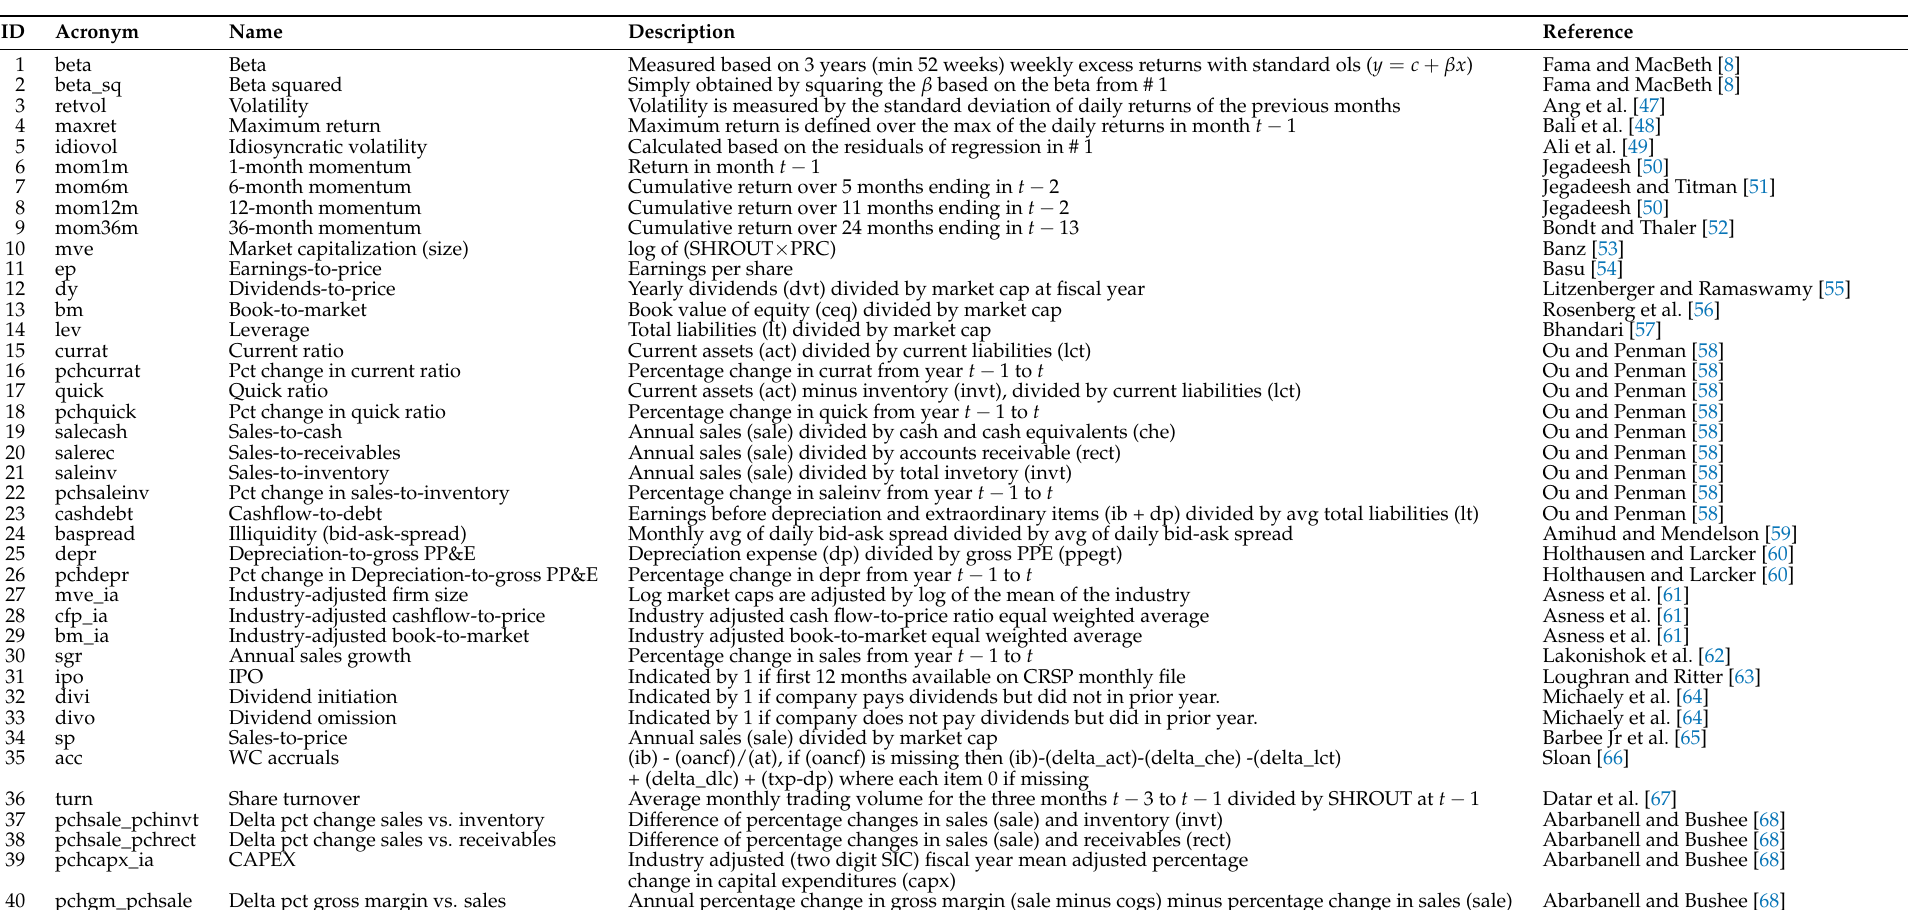
Table A2. The table displays the firm characteristics used. Most definitions are taken from Green et al. [3]. If not otherwise stated, accounting ratios always refer to fiscal year end